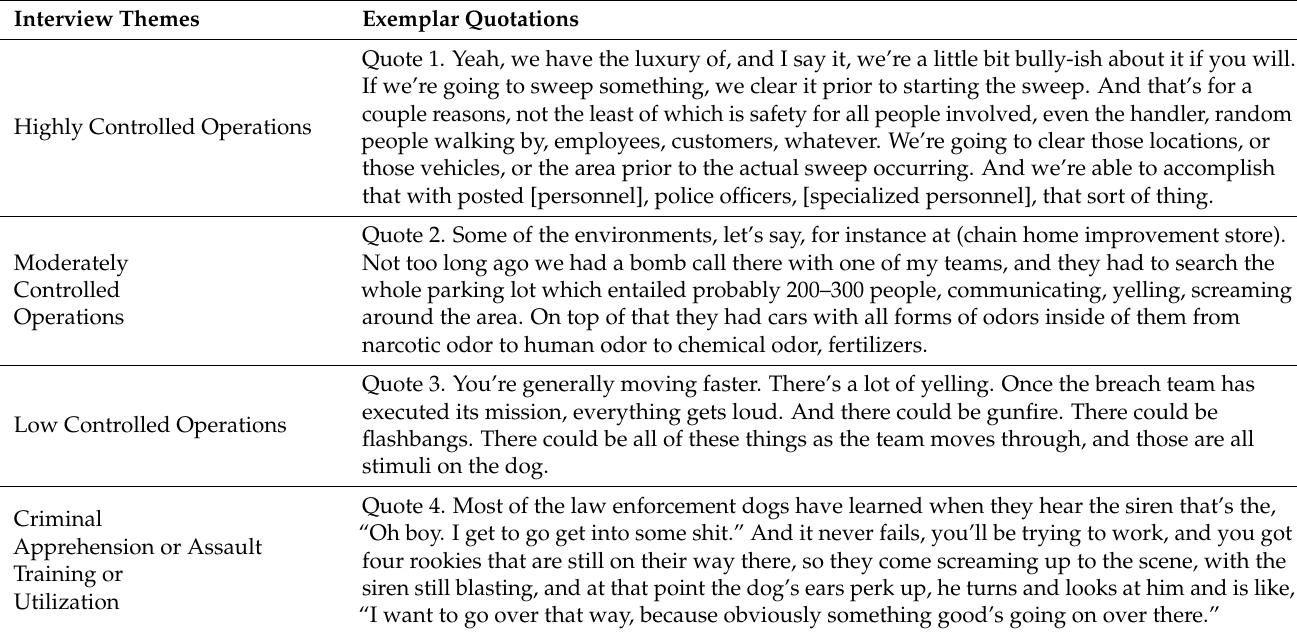
Table 1. EDC utilization factor themes and exemplar